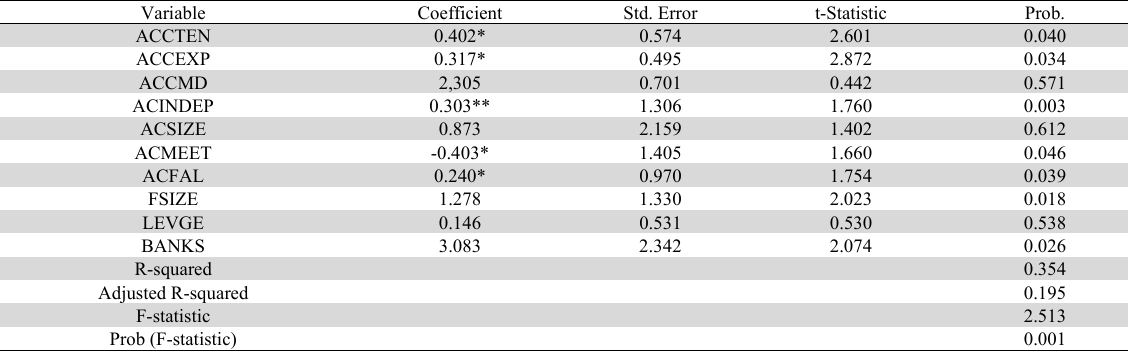
The Model Results of